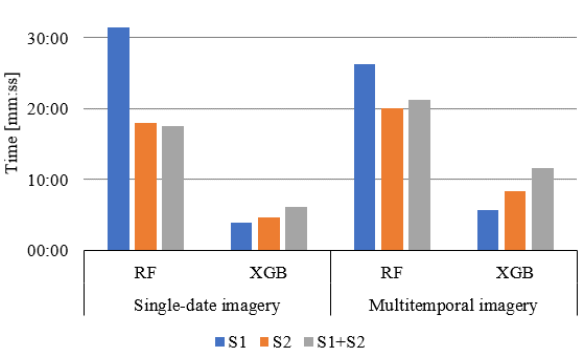
Figure 3. The computational time required for a single-date and MT classification using RF and XGB